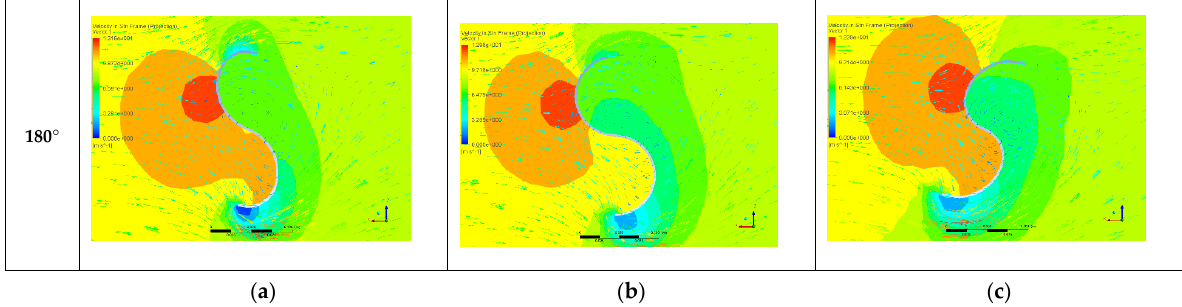
Figure 10. Velocity and pressure field for ( a ) Fibonacci I at TSR = 0.514 ( ω = 37 rad/s); ( b ) Savonius at TSR = 0.507 ( ω = 35 rad/s); ( c ) Fibonacci II at TSR = 0.506 ( ω = 37 rad/s).